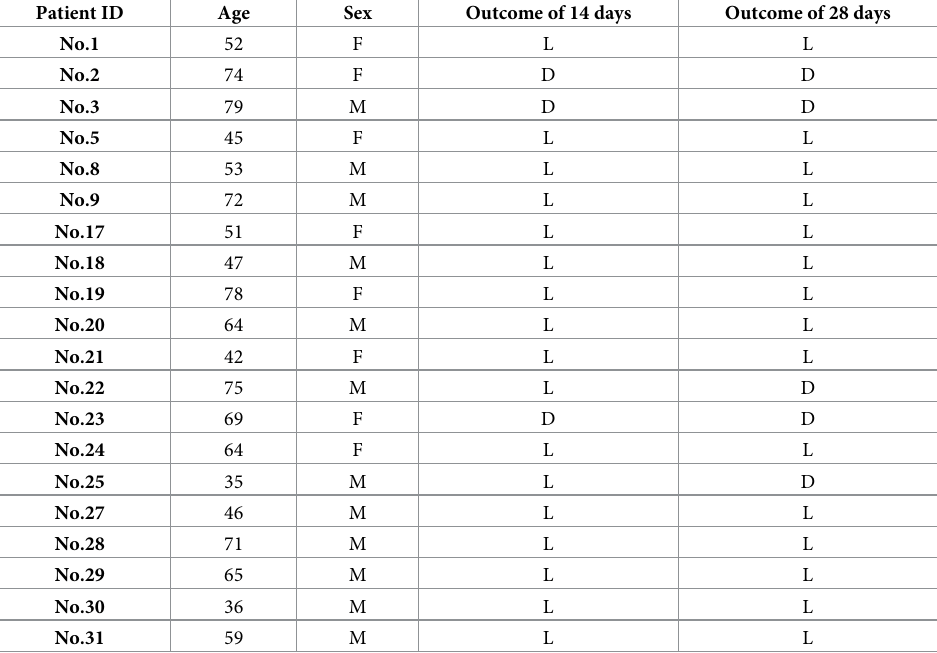
Information such as patient ID, age, sex of patients and treatment outcome after 14 and 28 days are included. “F” represents female; “M” represents male. “L” indicates survival up to the specified time; “D” indicates